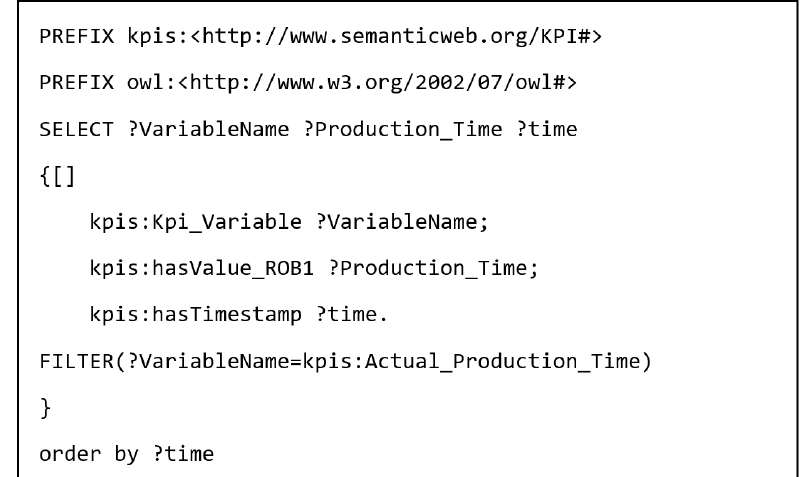
Figure 9. An example of SPARQL query for selecting specific data from the RDF store.